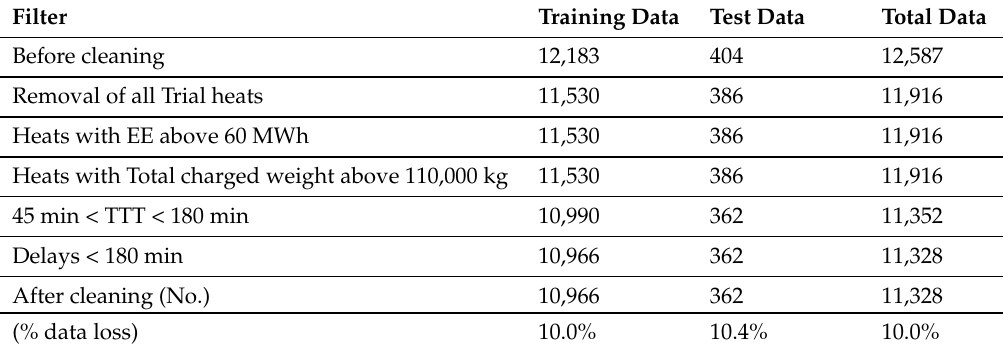
Table 9. The remaining data from the domain-specific cleaning rules that were applied to the data. The training and test data were selected as described in Section